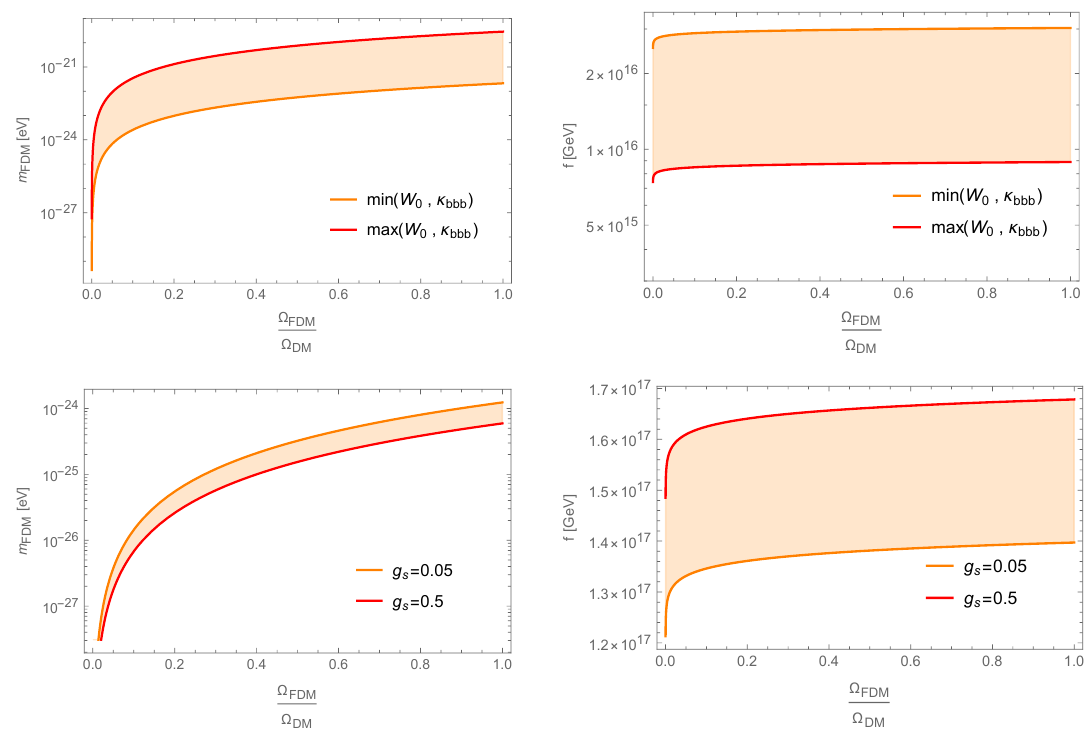
Figure 6 . Predictions for C 2 axion mass (left) and decay constant (right) in LVS (top) and KKLT (bottom) scenarios. The axion receives a mass through ED1 instanton effects coming from an ED1 brane wrapping the volume